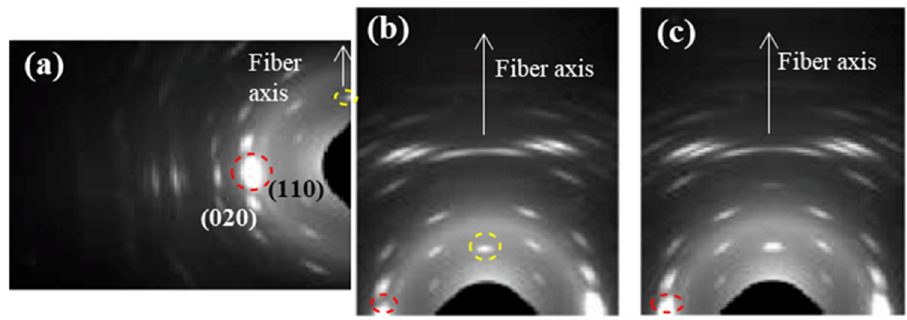
Figure 8. WAXD patterns of an annealed suture submitted to low (i.e., pH 10, 37 °C, 27 days) ( a,b ) and high (i.e., pH 3, 55 °C, 27 days) ( c ) degradation processes. Only a region of the reciprocal space is registered due to the specific configuration of the beamline that allows recording simultaneously SAXS and WAXD patterns. ( a , b ) Patterns were obtained from different orientations of the suture in the holder in order to get information of both equatorial ( a ) and meridional ( b ) reflections. Common meridional and equatorial reflections are indicated by the dashed yellow and red circles.